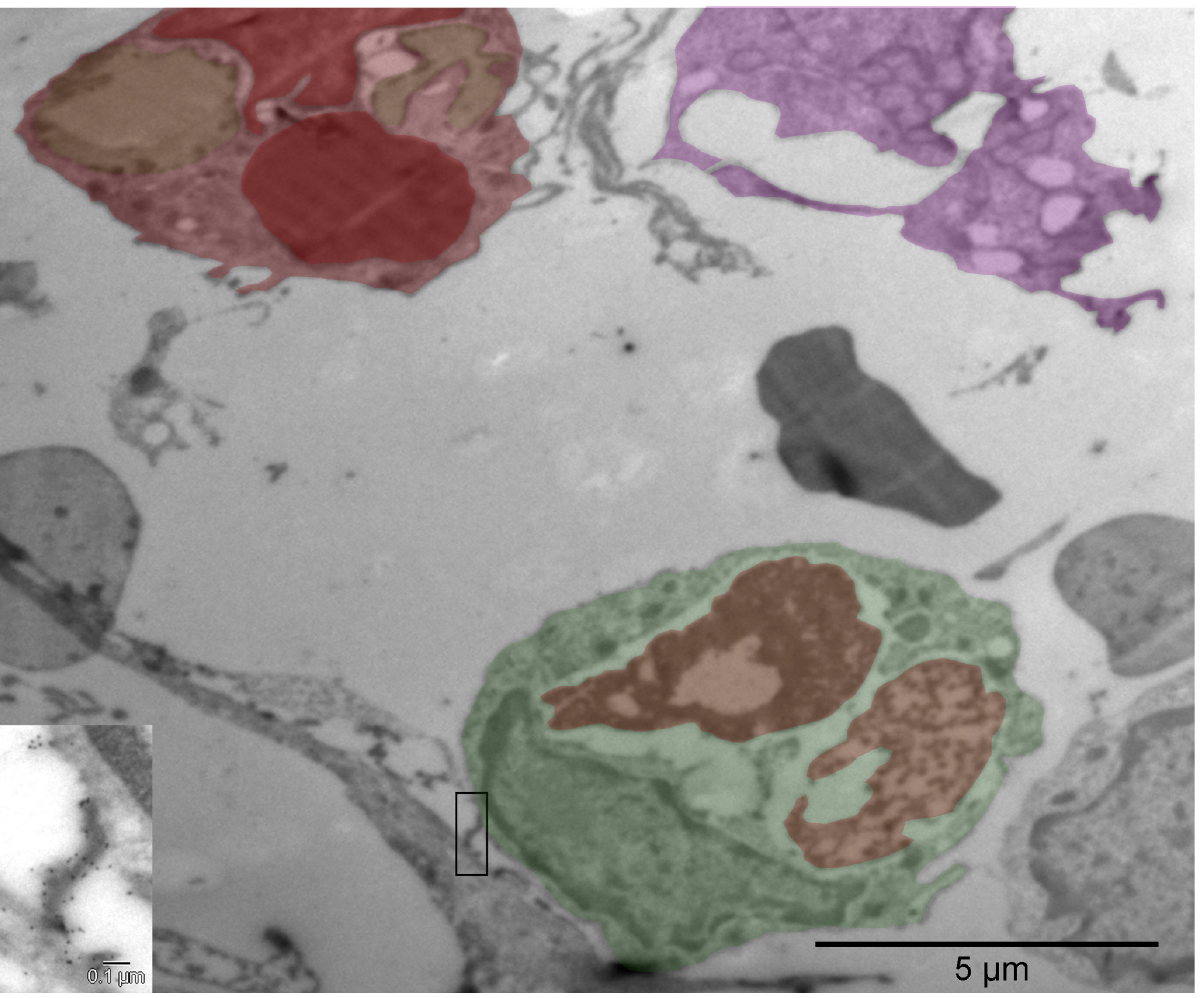
Figure S7. Relative location of megakaryocyte (purple), erythroblast (red) and ECs (green) precursors in situ . Compare with Figure S4 [A, B & C]. The insert shows calmyrin-containing extracellular fibers connecting the adjacent cells.